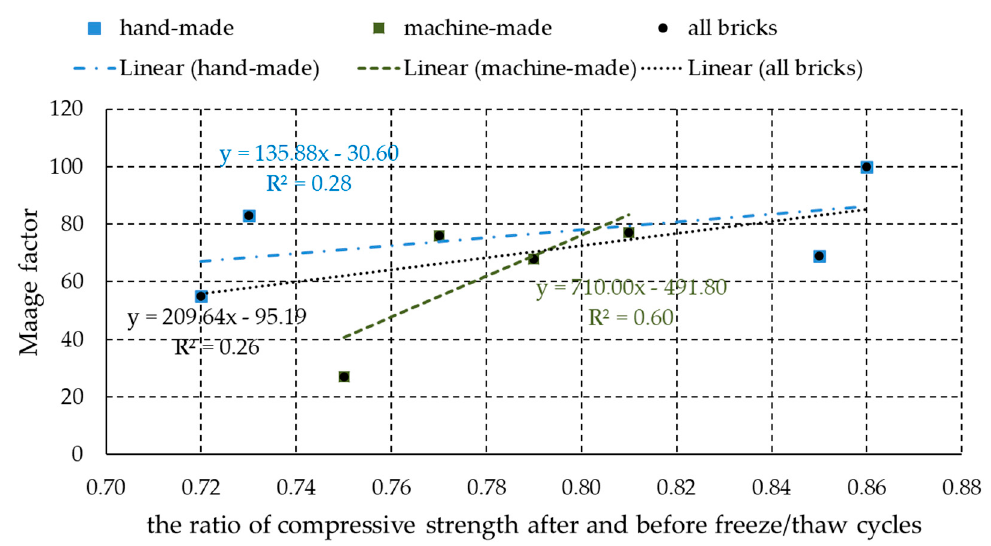
Figure 10. Ratio of compressive strengths before and after freeze–thaw cycles vs. the Maage factor.